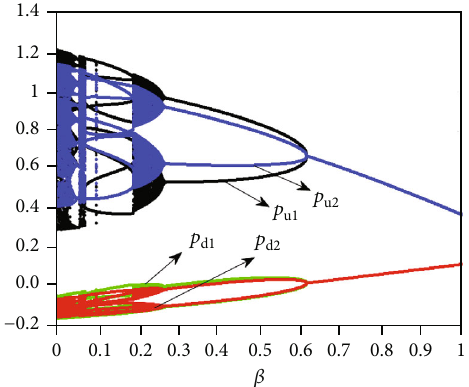
Figure 6: Stable area of ð λ